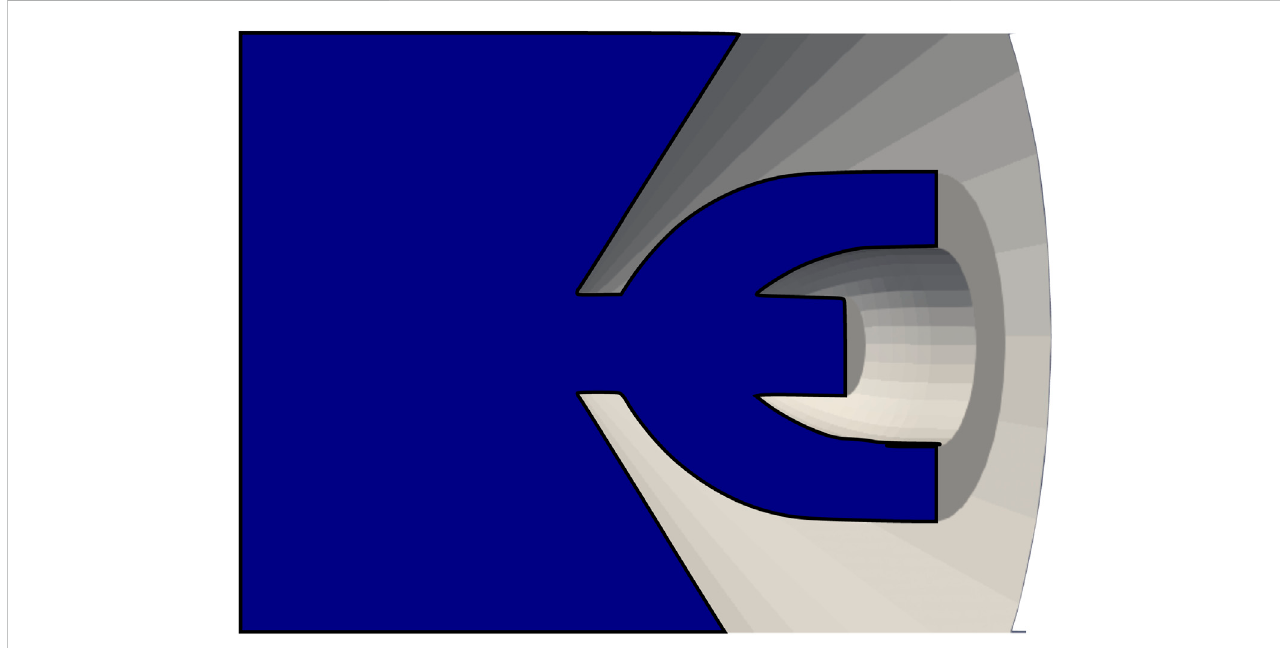
FIGURE 5 Computational fl ow fi eld for the GDVN with bell-shaped geometry for the gas fl ow fi eld. Blue surface represents the surface of symmetry.